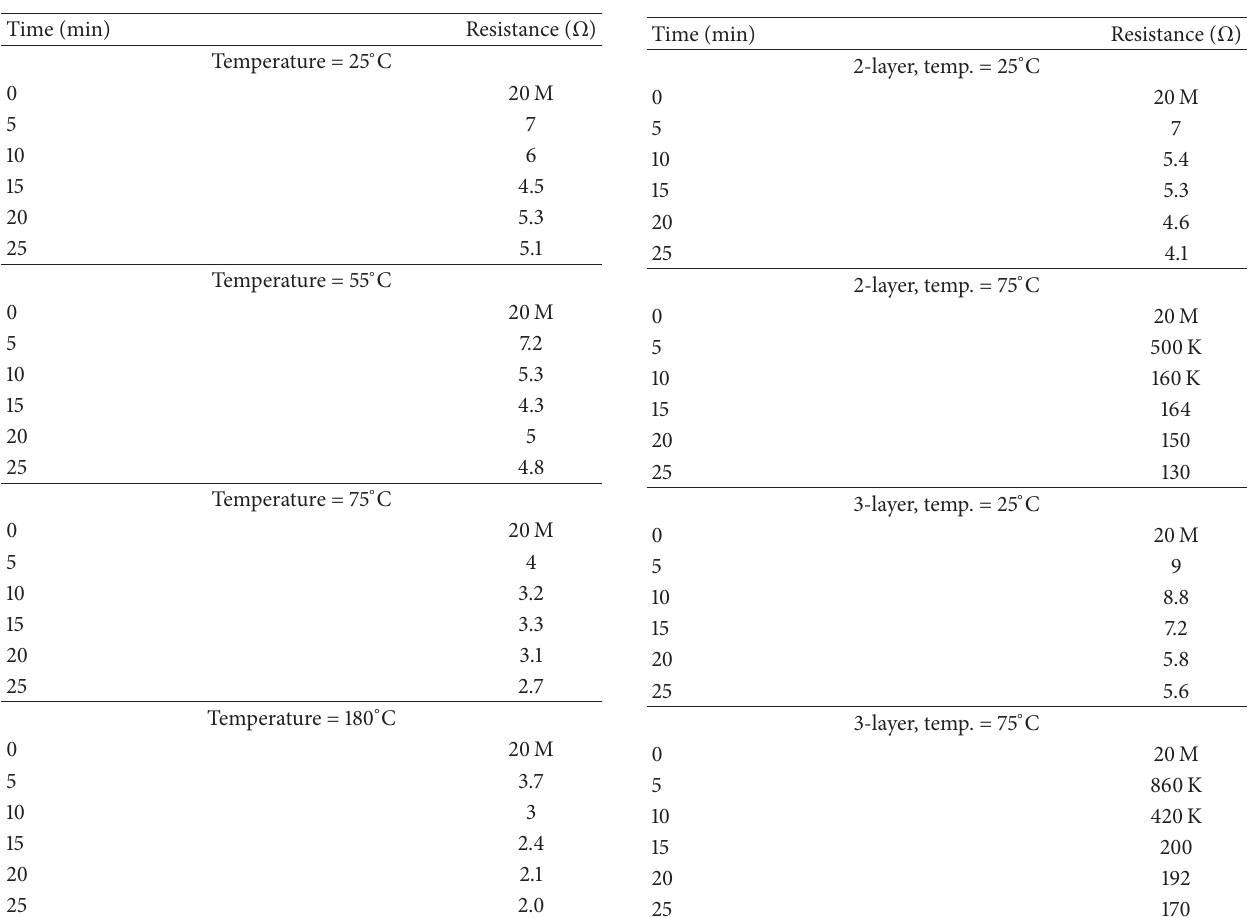
Table 1: Effect of temperature of one-layer sample on resistance in Ω /cm.